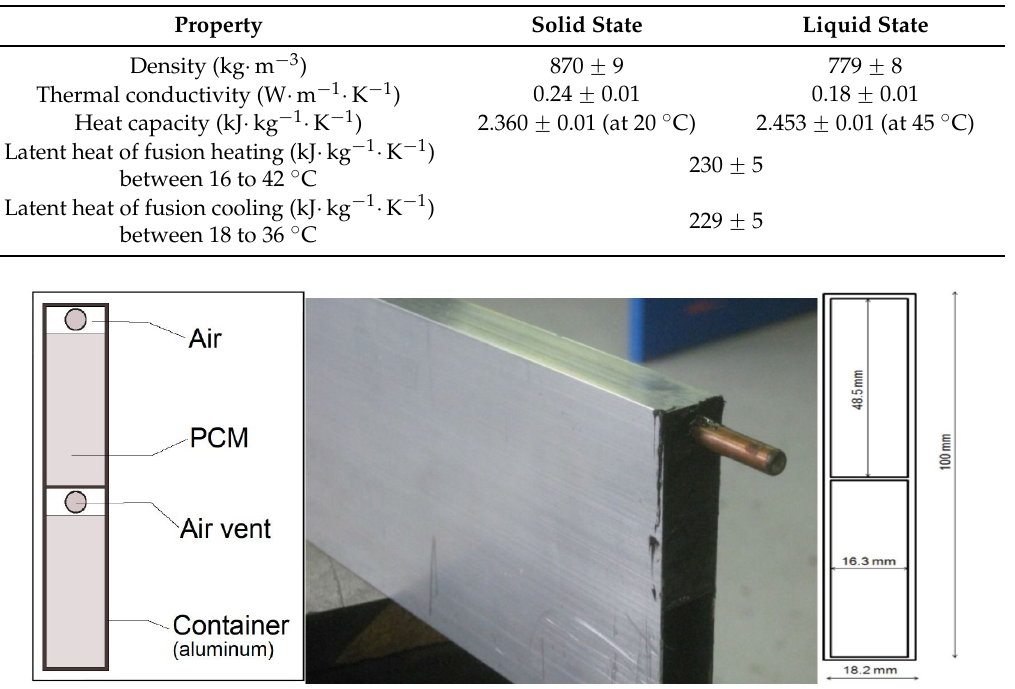
Figure 3. Schematic diagrams and photograph of a single container filled with phase change material (PCM).